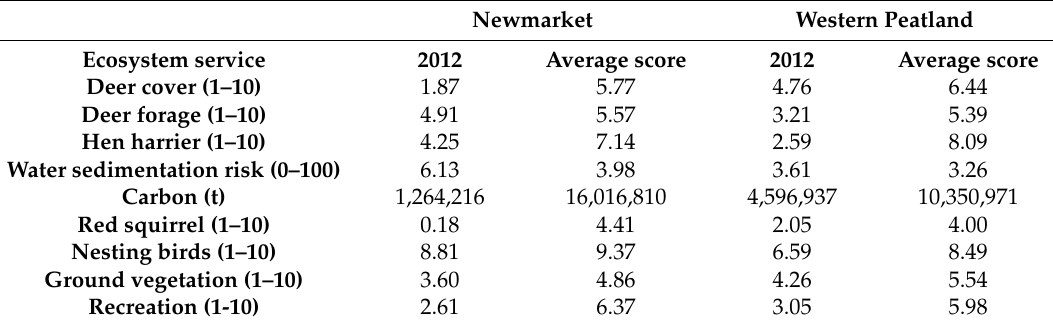
Table 5. Comparing the average ecosystem service scores with the initial 2012 ecosystem service scores. Note the Newmarket case study area includes agricultural land from this point on in the study and, as a result, the ecosystem service provisions from the two case study areas are not